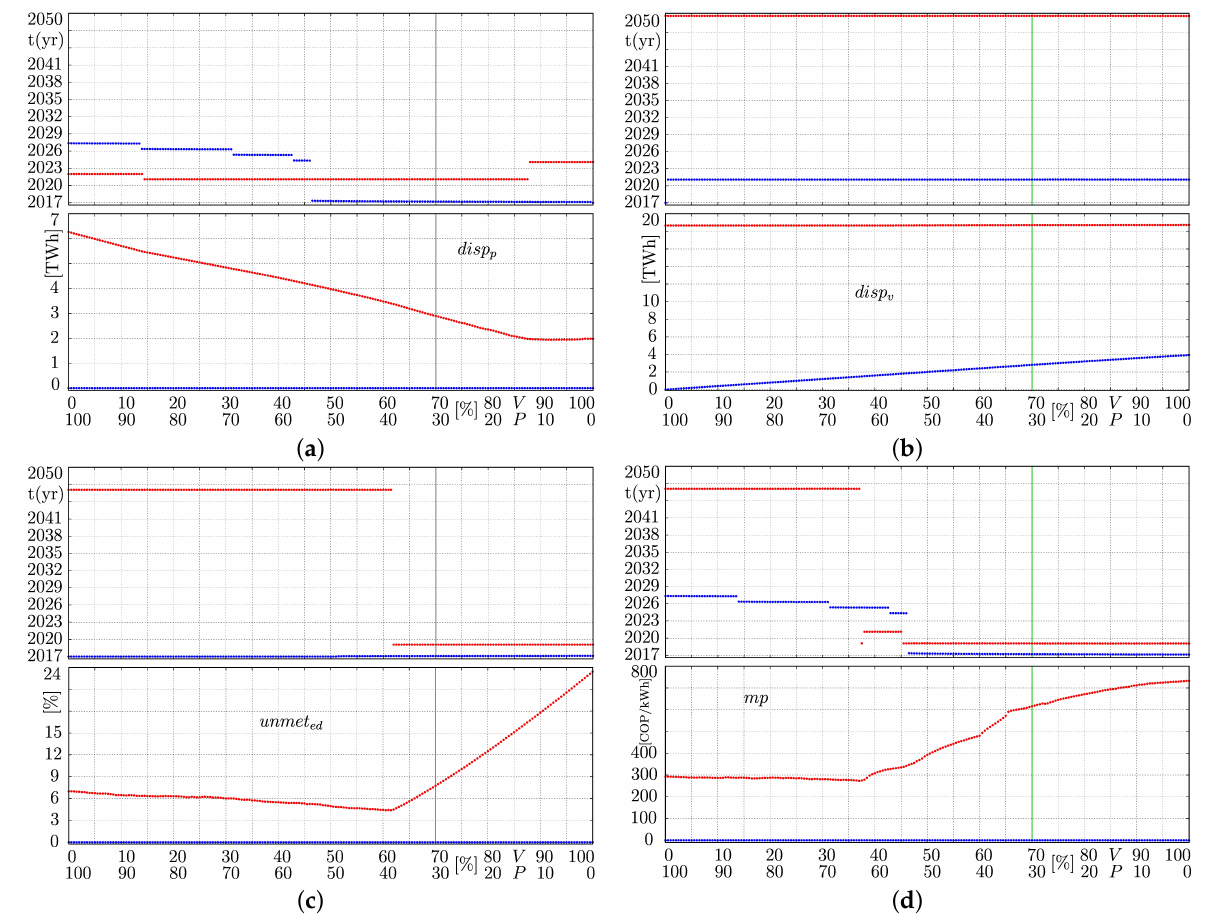
Figure 13. Confidence limits of the V / P scenarios and their time of occurrence. The red and blue lines represent maximum and minimum values, respectively. The green vertical line represents the Colombian case (70%V, 30%P). ( a ) disp p , ( b ) disp v , ( c ) unmet ed , and ( d ) mp